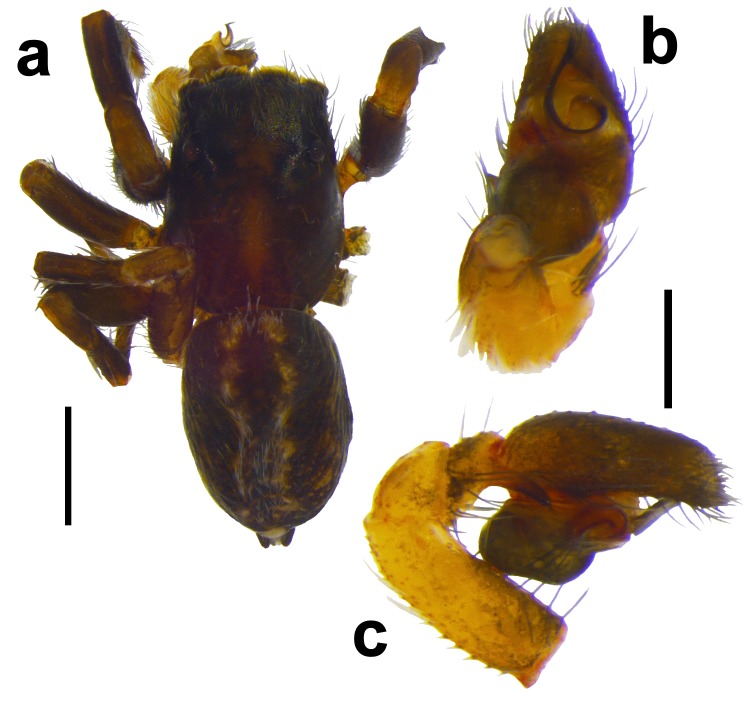
Pseudeuophrys
nebrodensis Alicata & Cantarella, 2000. a: male, dorsal habitus, scale = 0.8 mm; b: left male palp, ventral, scale = 0.2 mm; c: left male palp, retrolateral, scale = 0.2 mm.